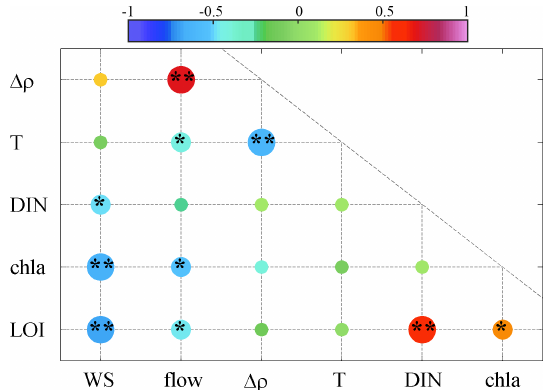
speeds (WS), freshwater discharges (flow), vertical density differ- ences ( (cid:49)ρ ), bottom temperature ( T ), surface DIN concentrations (DIN), surface Chl a concentrations (Chl a ), and low-oxygen index (LOI). Note that the color of the dots shows the correlation coeffi- cients, and the symbols * and ** represent the significance level at p< 0 . 05 and p< 0 . 01,